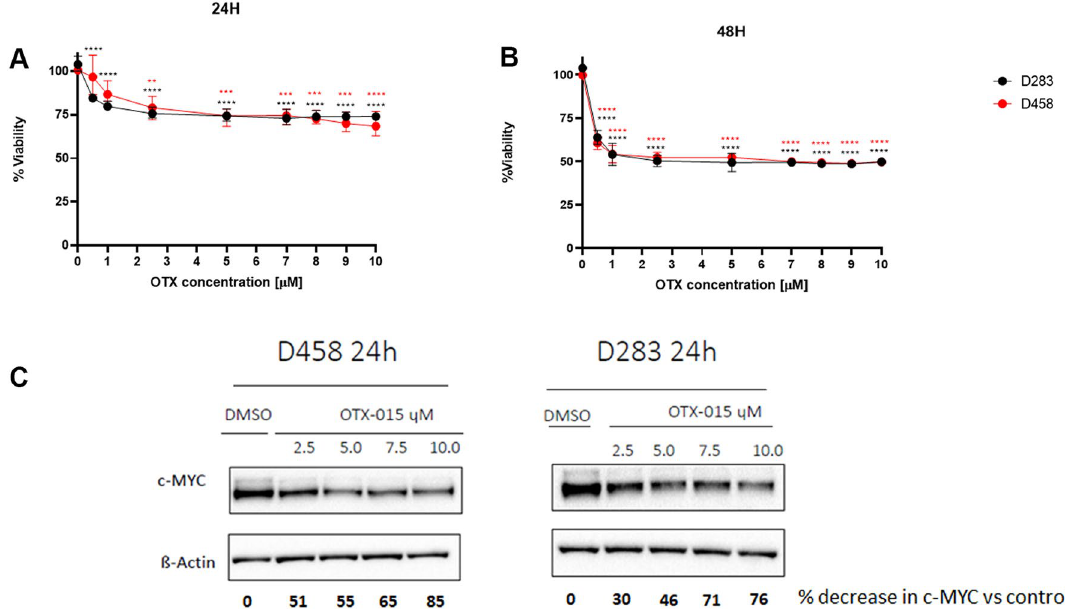
Figure 1. OTX-015 inhibits the viability of D458 and D283 MB cell lines. D458 (red) and D283 (black) were treated with different concentrations of OTX-015 spanning from 0 to 10 µM as indicated for ( A ) 24 and ( B ) 48 h. Statistical significance of cell viability inhibition was performed using one-way ANOVA with **; *** and **** indicating p < 0.05, < 0.005 and < 0.0001, respectively. ( C ) Representative Western blot showing MYC downregulation upon treatment with OTX-015 (2.5, 5.0, 7.5, and 10.0 µM) for 24 h. Bold numbers indicate percentage reduction of normalised c-MYC (c-MYC/β-Actin) versus control (DMSO). Original Western blots are presented in Supplementary Fig.